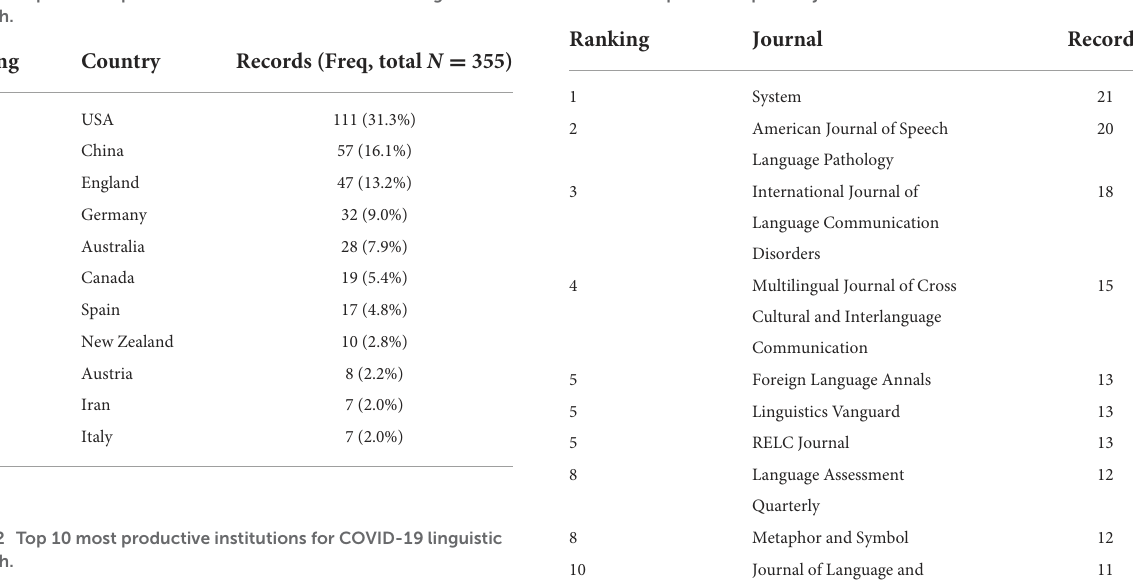
TABLE 3 Top 10 most prolific